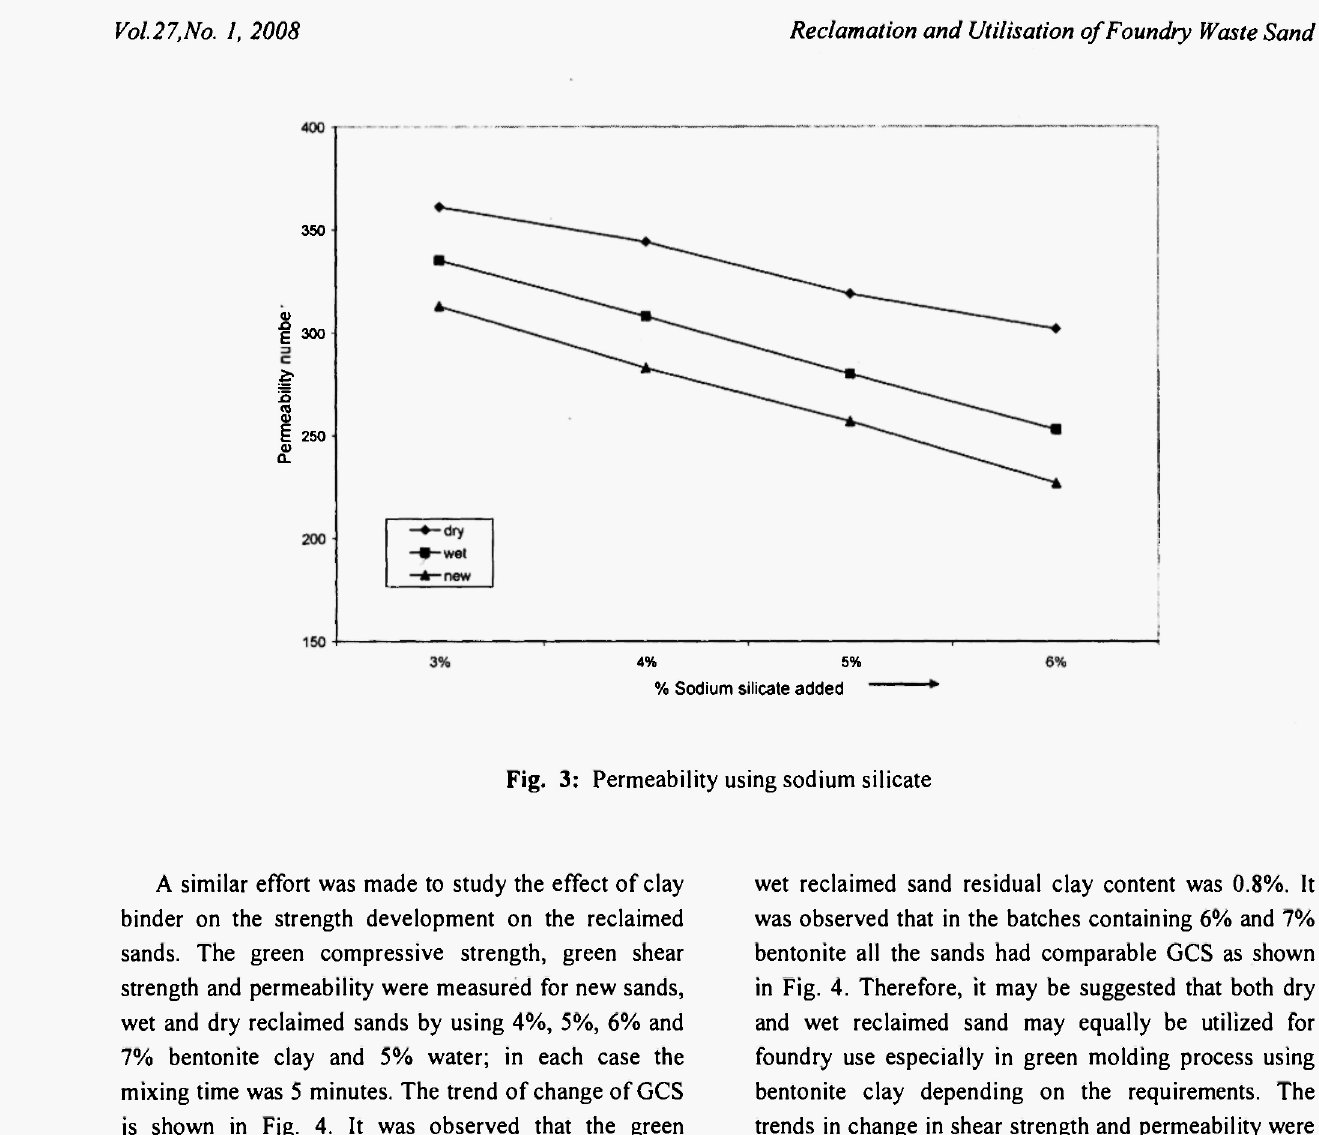
Fig. 3: Permeability using sodium